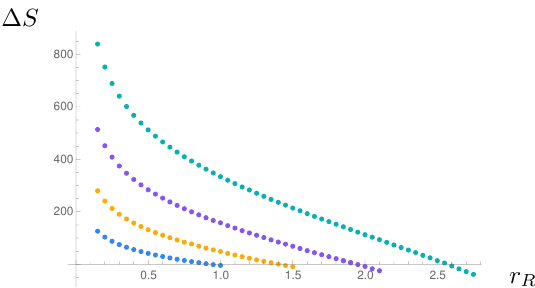
Figure 7 . Area difference ∆ S = S island − S HM as function of the anchor point r R in the asymptotic AdS 5 × S 5 region. The defect is at r = ∞ , the horizon at r h = 0 . For ∆ S > 0 the HM surface dominates at t = 0 . The radius of the AdS 5 × S 5 region is controlled by N 5 K , the number of defect degrees of freedom by N 2 . The color-coded dots are, from top to bottom, for N 5 /K ∈ 5 { 1 . 2 , 1 . 6 , 2 . 0 , 2 . 4 } with K = 1